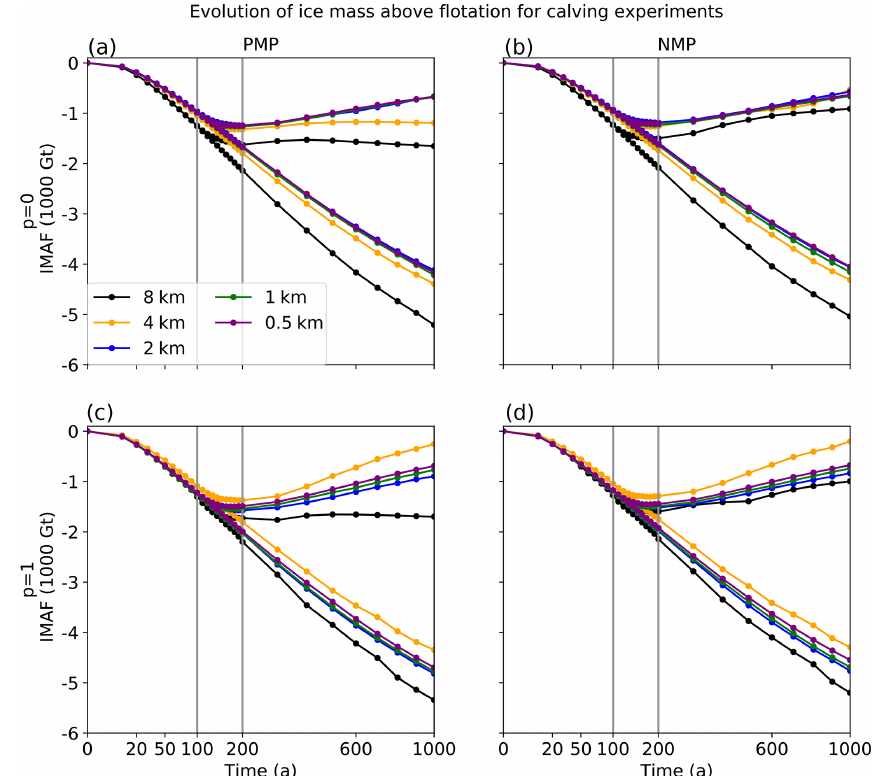
Figure 13. Evolution of IMAF relative to steady state for the full set of calving experiments. The layout is the same as in Fig. 11, but for Ice2 instead of Ice1 protocols.